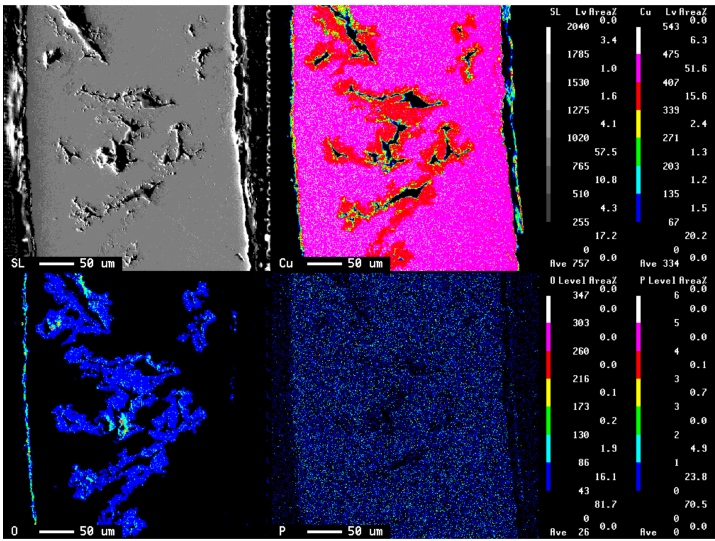
Figure 5. The result of SEM image of the copper tube after being immersed 30 days in 10 3 ppm Cu(HCOO) 2 ; EPMA led to corresponding elements of copper, oxygen, and